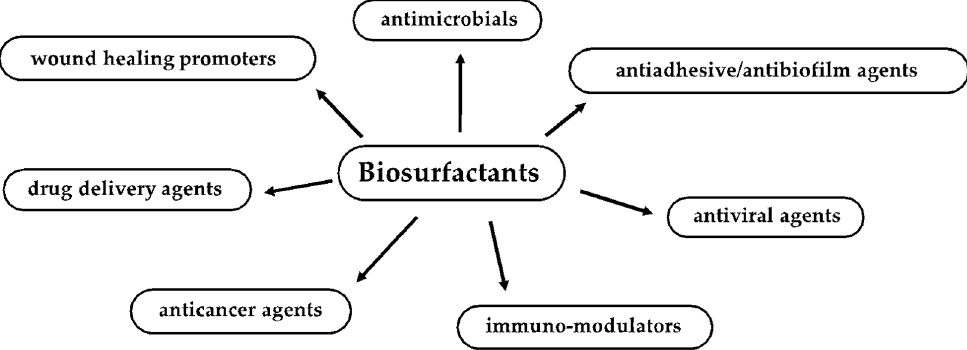
Figure 1. Biomedical, therapeutic and pharmaceutical applications of biosurfactants.